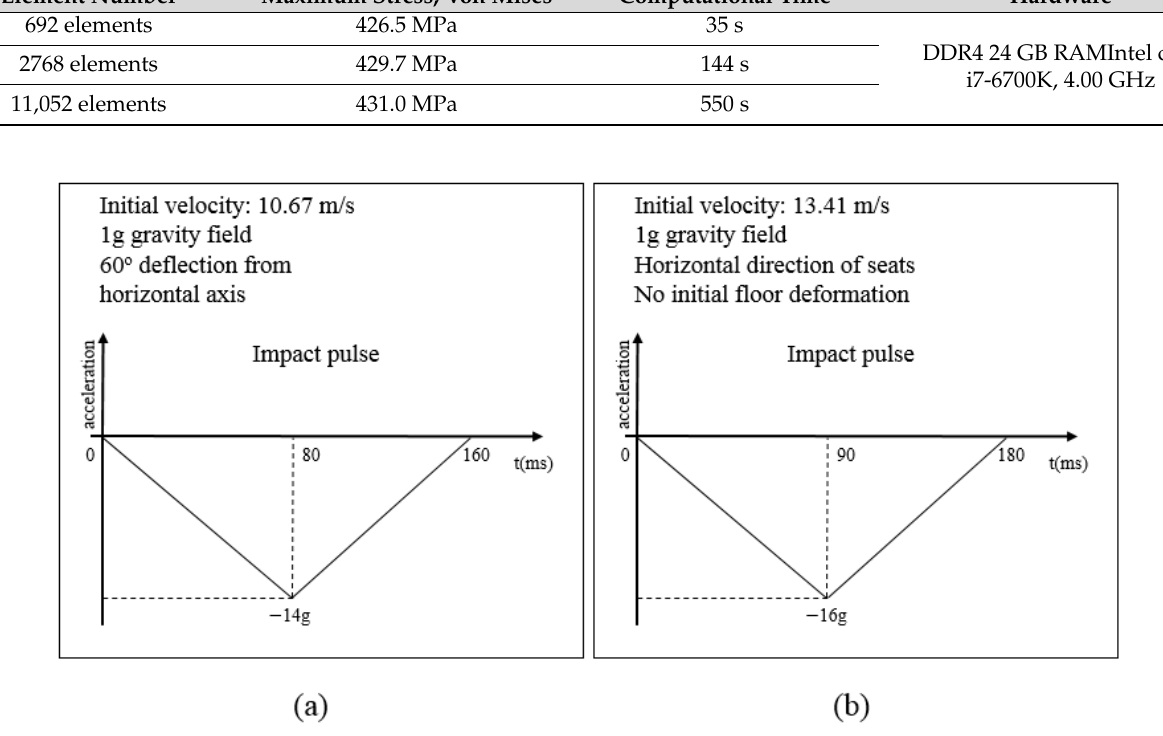
Figure 9. Loading conditions of ( a ) test 1 and ( b ) test 2 and test